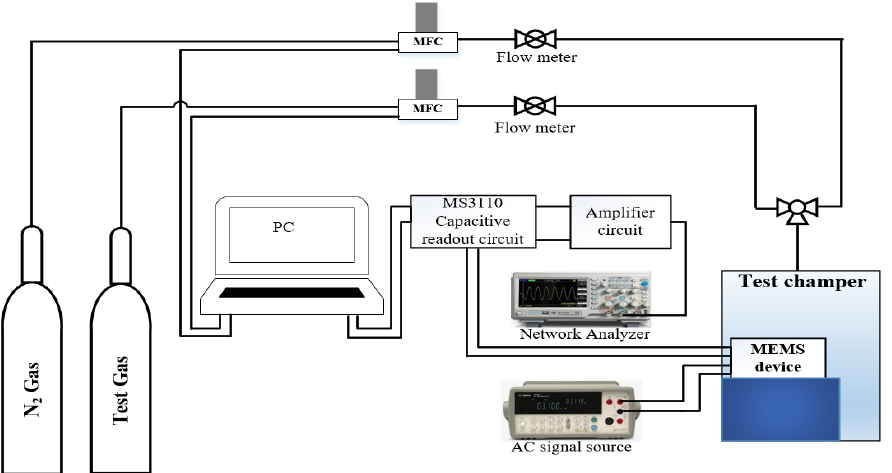
Figure 21. Block diagram of gas flow